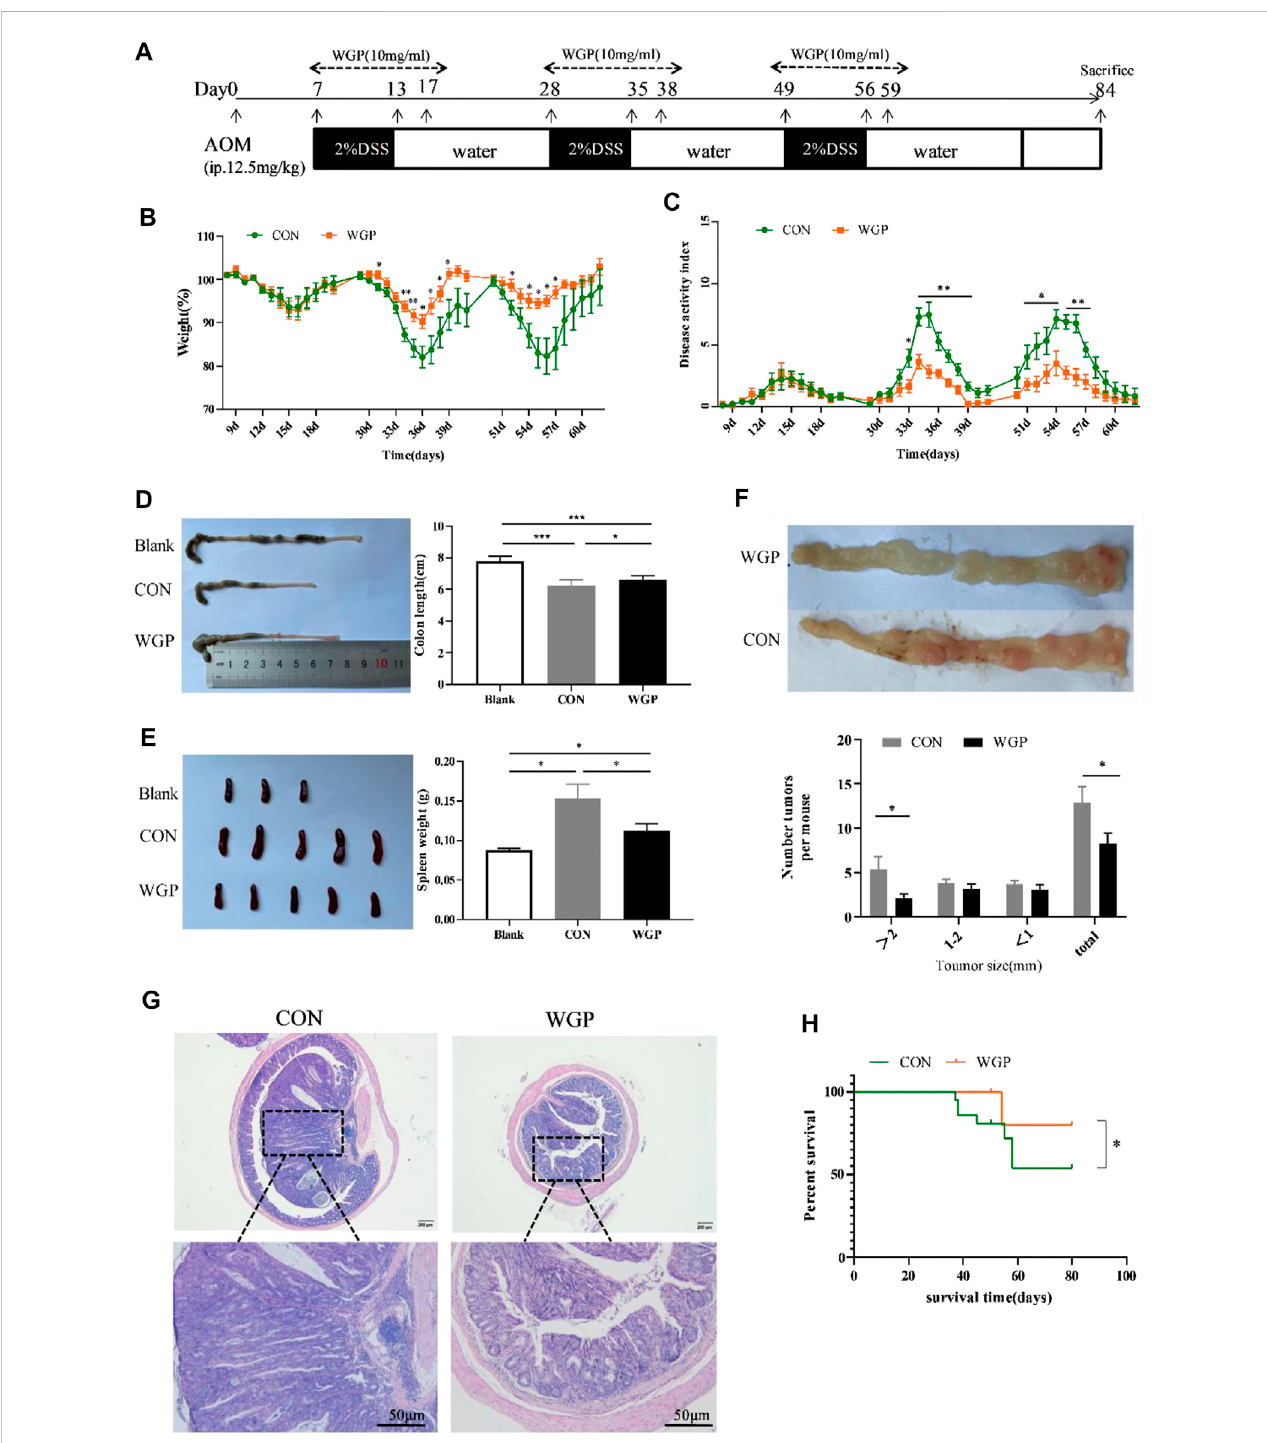
FIGURE 1 WGP treatment can attenuate colitis-associated colorectal cancer (CAC). (A) Induction procedure for AOM/DSS-induced CAC in C57BL/6 mice and WGP administration. (B – C) Body weight (B) and disease activity index during each treatment cycle (C) of mice that received 2% DSS-containing water (CON group, green dotted line) or 2% DSS combined with WGP orally (WGP group, orange dotted line). For statistical comparisons, an asterisk indicates CON vs. WGP. (D – F) Colonlength (D) ,spleenweight (E) ,andthenumberoftumorrepresentativepicturesofcolonsandthesizedistributionofcolorectaltumors (F) at Day 84 in AOM/DSS-induced mice treated with or without WGP. (G) Representative H&E stained images and corresponding tumor area of distal colon cross-sections. (H) SurvivalcurvesofmicetreatedwithwaterorWGP,* p < .05bylog-ranktest.Dataarerepresentativeofthreeindependentexperimentswith n = 8 – 10 mice per group. The statistical signi fi cance of differences was determined by multiple t tests (B,C,F) and one-way ANOVA (D,E) . * p < .05, ** p < .01, *** p < .001. The results are presented as the means ±